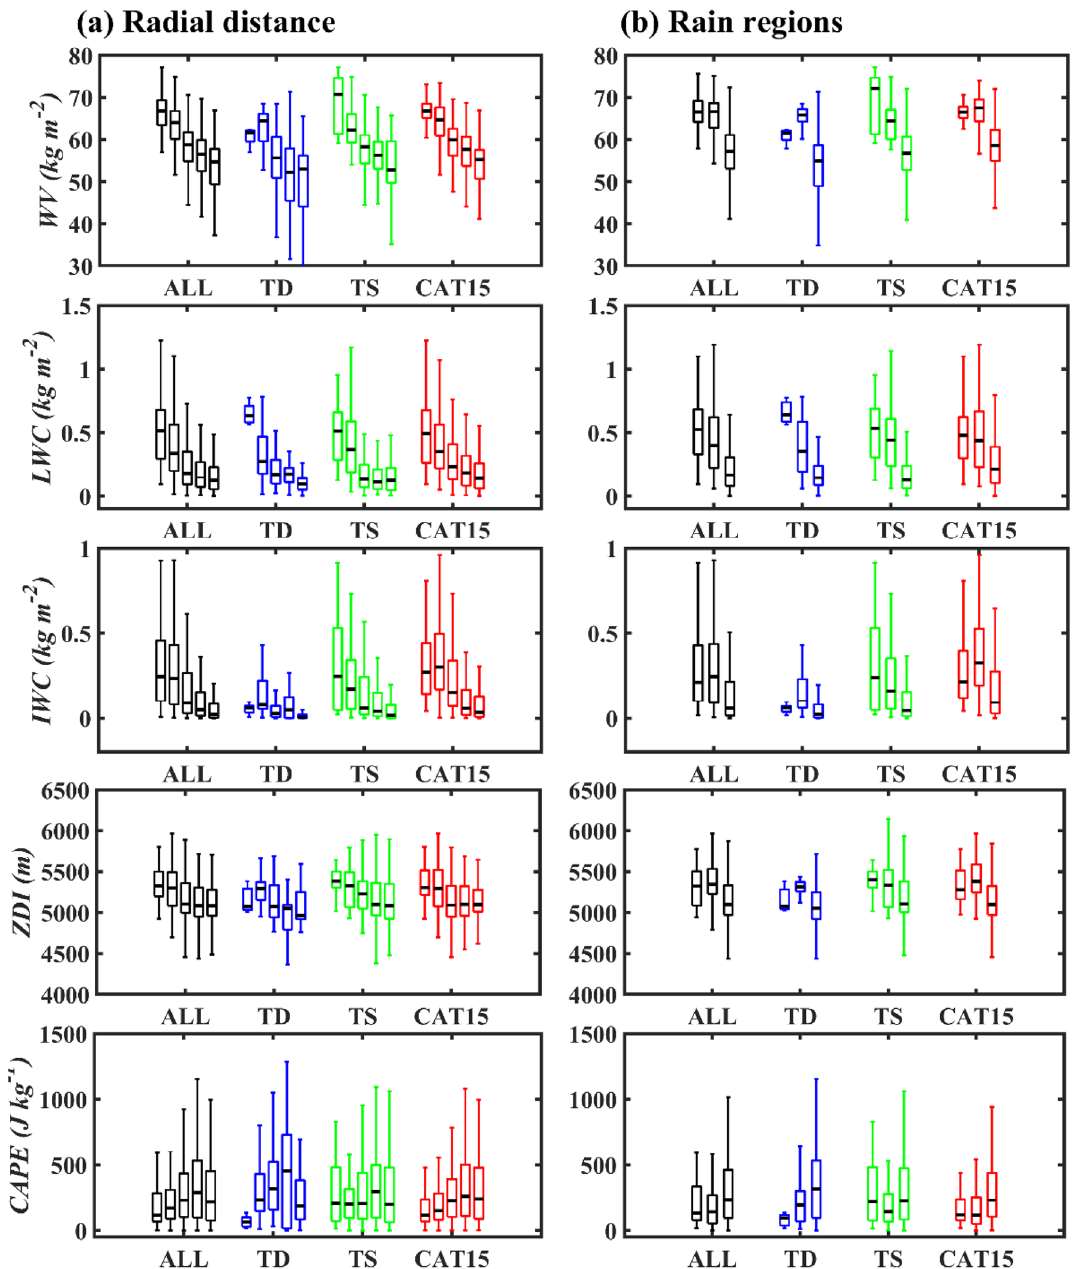
Figure 7. Cloud and precipitation parameters of TCs. Distribution of water vapor ( WV , Kg m –2 ), total column liquid water content ( LWC, Kg m –2 ), total column ice water content ( IWC , Kg m –2 ), zero degree isotherm ( ZDI , m), and convective available potential energy ( CAPE , J Kg –1 ) for All, TD, TS, and CAT15 TCs at ( a ) different radial distances (RD1 to RD5) and ( b ) rain regions (IC, IB, and OB). Five box plots (from left to right) for each category TCs in ( a ) corresponds to RD1 to RD5. Three box plots (from left to right) for each category TCs in ( b ) corresponds to IC, IB, and